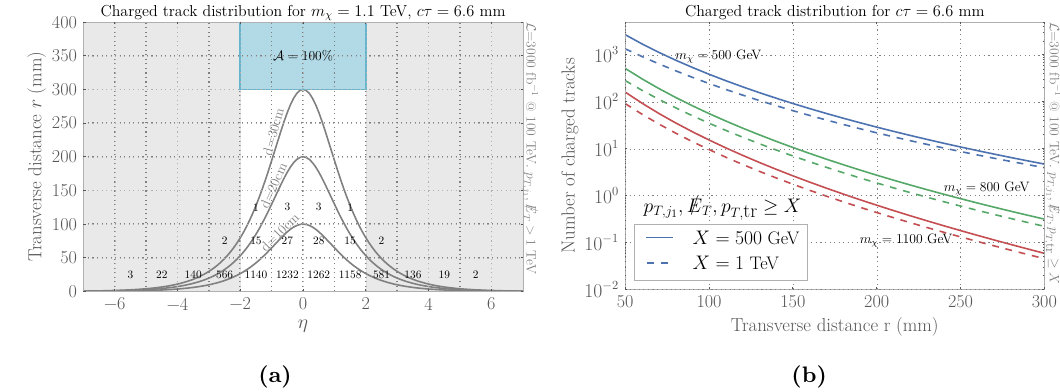
Figure 4. Distribution of number of charged tracks for weak-doublet fermion (cid:31) pair-produced at FCC-hh, as a function of r (mm), (a) binned in (cid:17) and rounded down to the nearest integer, for m (cid:31) = 1 : 1 TeV and p T ( j 1 ) ; =E ; p T; tr > 1 TeV and (b) integrated over T and p T ( j 1 ) ; =E > X . The lifetime is chosen equal to that of the corresponding pure-Higgsino T